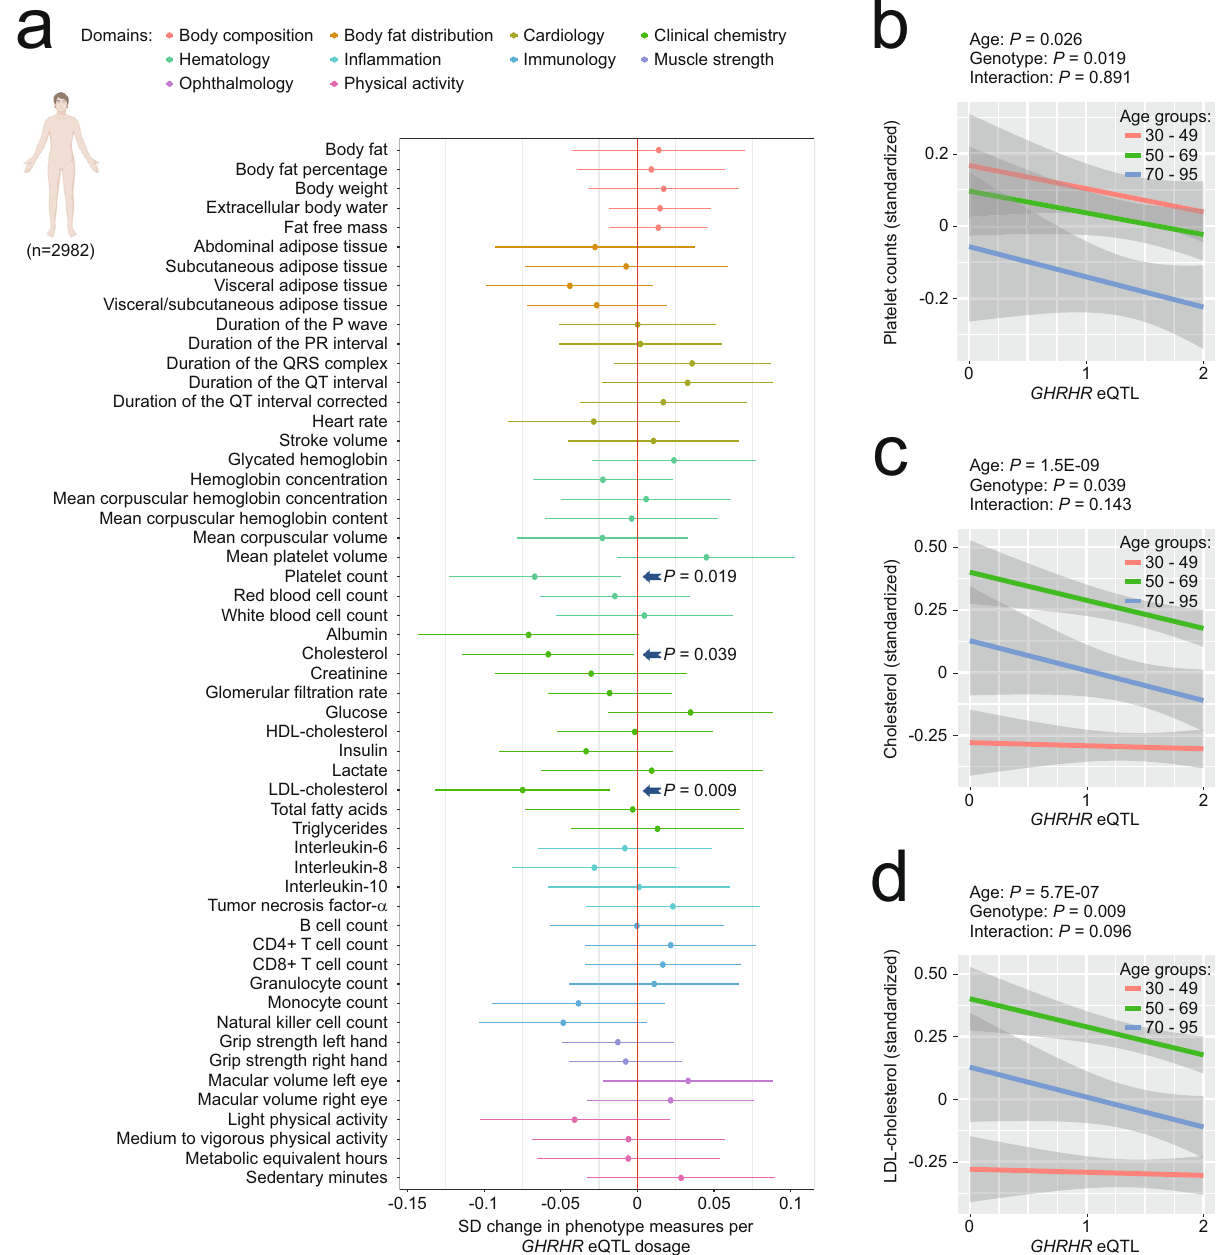
Fig. 5 | GHRHR eQTL effects on aging-associated phenotypes in humans. a – d Phenotyping results in a large deep-phenotyped human cohort that included participants of both genders with an age range from 30 – 95 years. a Change in phenotype (in standard deviations (SD) from the mean) associated with GHRHR eQTL dosage with the horizontal whiskers indicating the 95% con fi dence intervals of the mean effect estimate; * denotes p <0.05 for the linear association between GHRHR eQTL dosage and phenotype The association between eQTL dosage and each phenotypic measure was assessed using multiple linear regression models adjusted for age, sex and population strati fi cation using the fi rst ten genetic